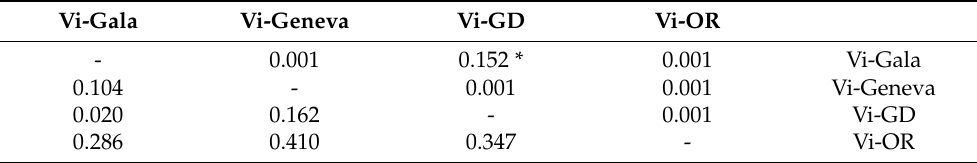
Table 3. Pairwise genetic distance (PhiPT) between the four investigated V. inaequalis